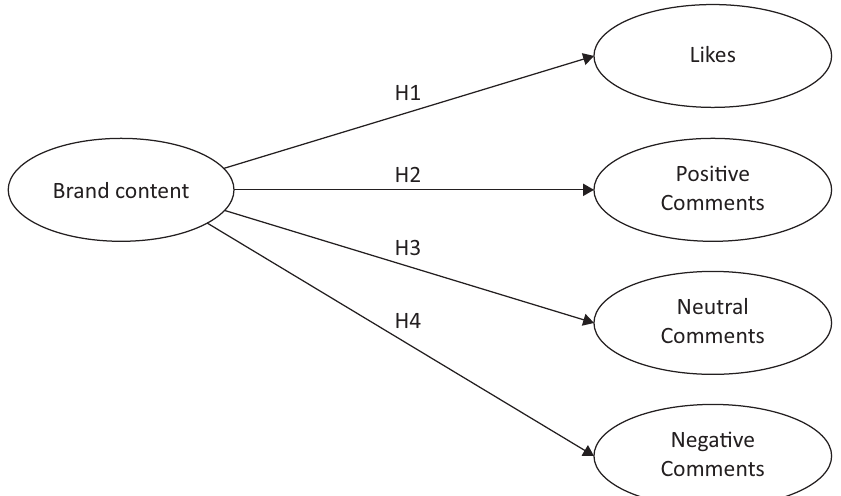
Figure 1. Model showing the effect of the Instagram brand context on followers interactions of the Manolo Blahnik and Loewe brands.